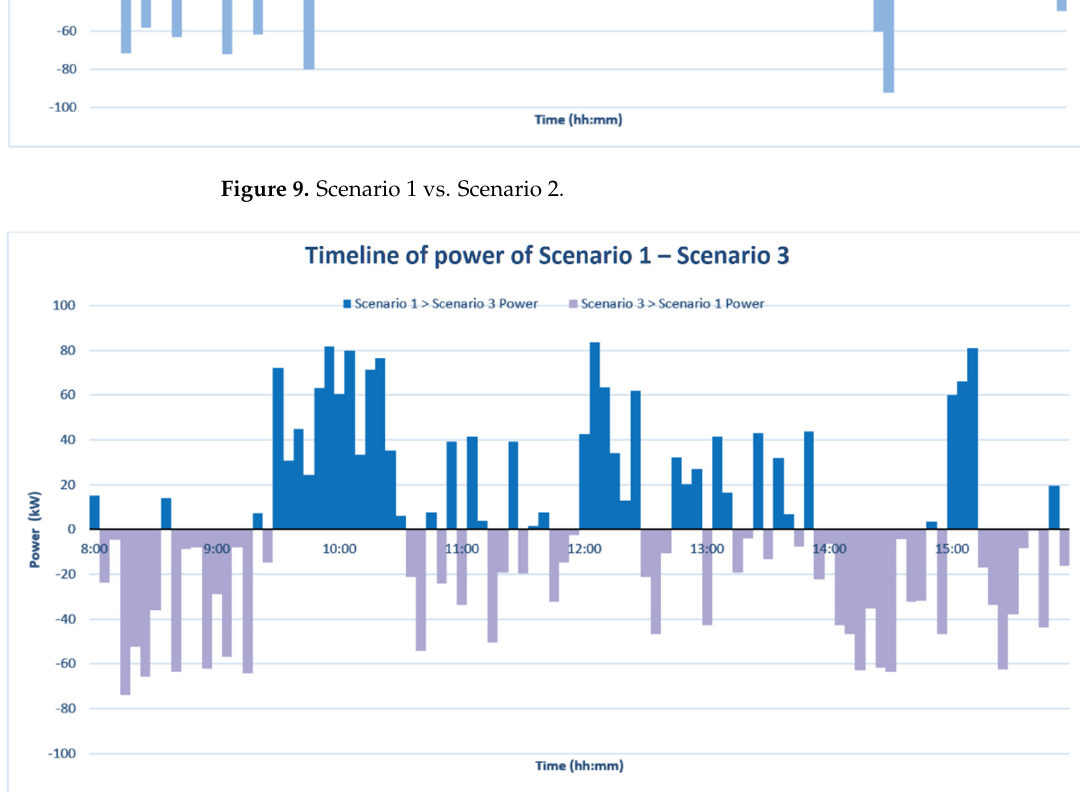
Figure 10. Scenario 1 vs. Scenario 3.